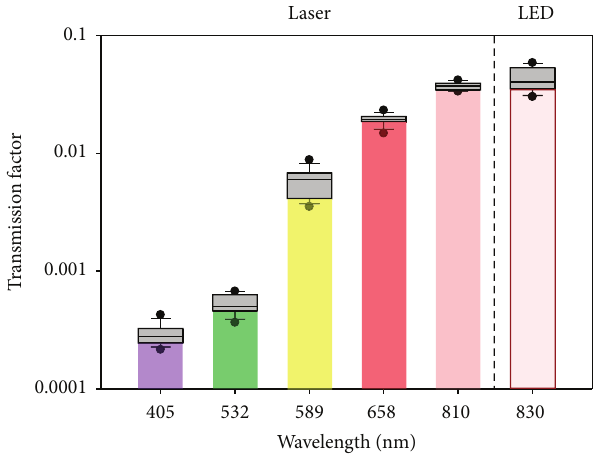
Figure 4: Transmission factor of different types of laser (modified from [20]) and of the new medlouxx system (LED). The results from violet (405 nm), green (532 nm), yellow (589 nm), red (658 nm), and infrared (810 nm) lasers are based on a previous study [20]. The system based on LED showed the highest mean value of the transmission factor (830nm infrared light). The lines in the boxes represent the median, the ends of the boxes define the 25th and 75th percentile, and the error bars define the 10th and 90th percentile.